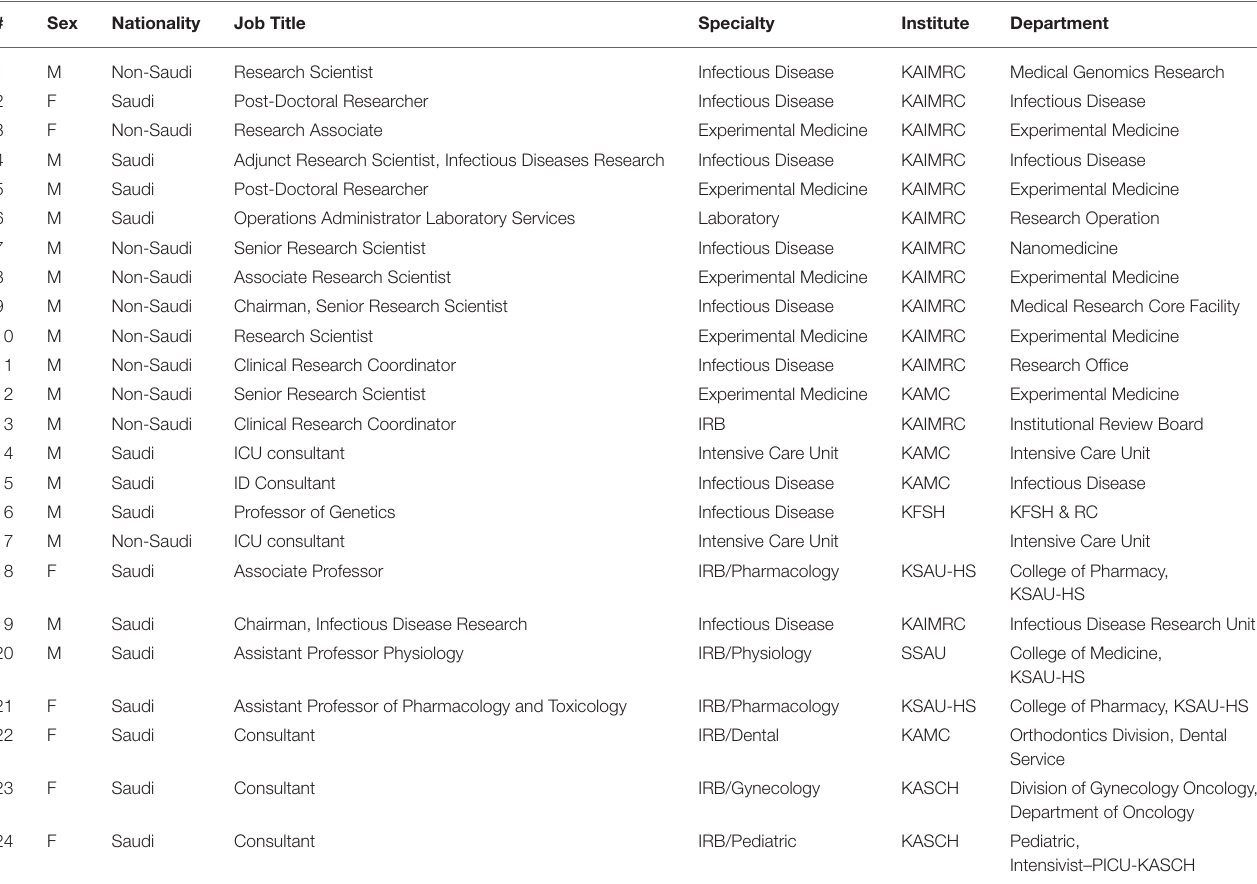
TABLE 1 | Characteristics of